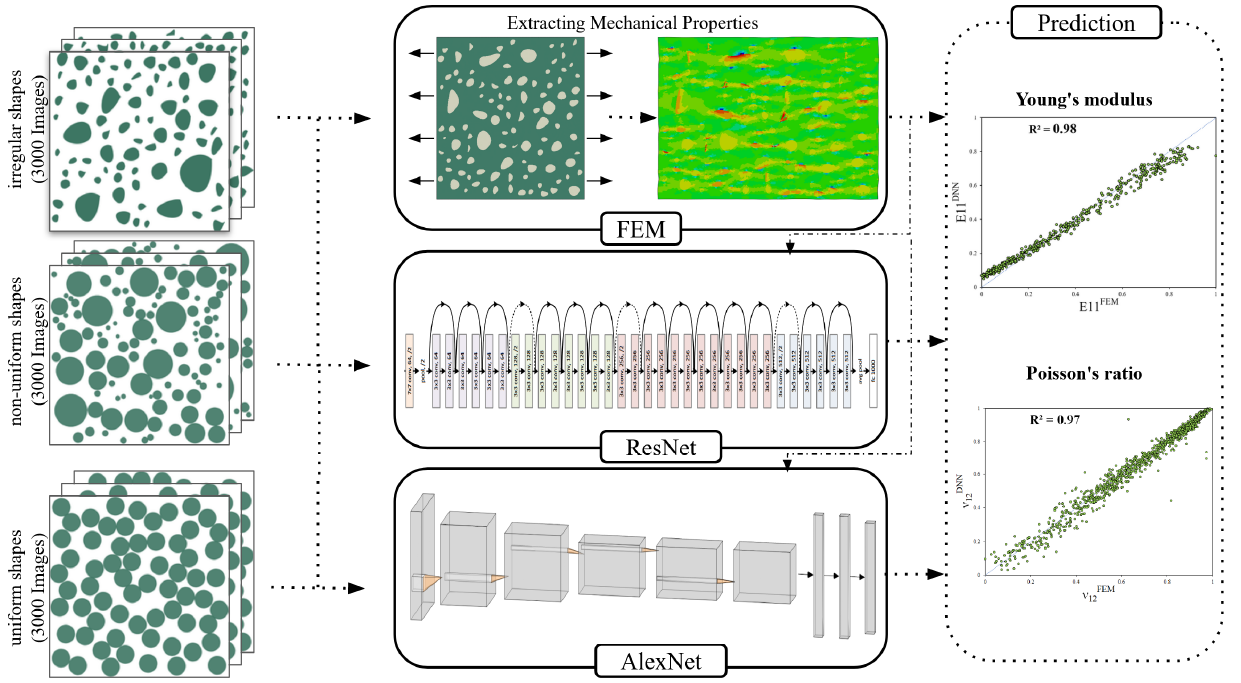
Figure 1. Overall framework that bridged FE analysis with DNN networks to predict the Young’s modulus and Poisson’s ratio of BGs-COL.